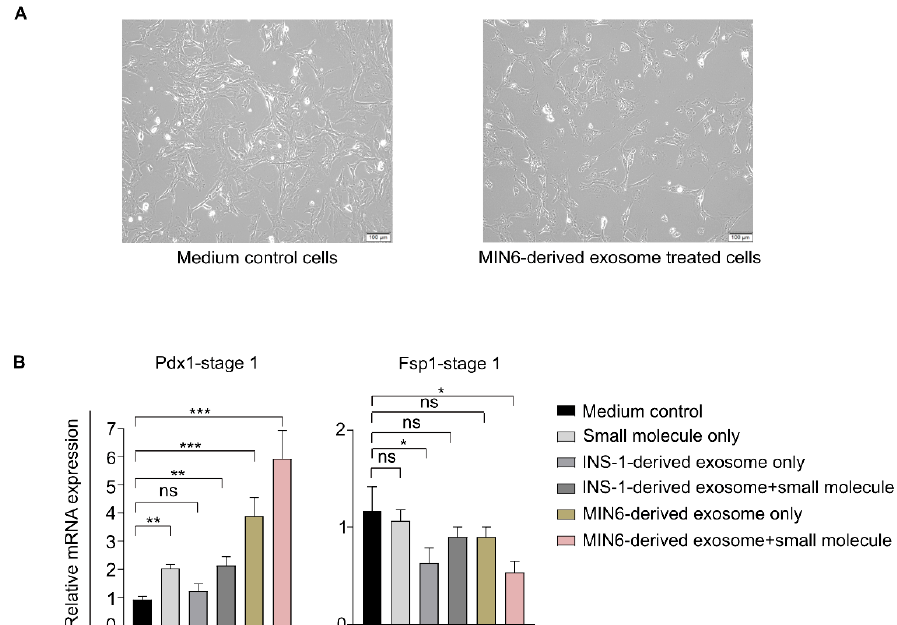
Figure 3. The pancreatic transcriptional program in MEFs treated with insulinoma-derived exosomes. ( A ) Bright-field microscopic images of the medium control and only MIN6-derived exosome-treated MEFs. The insulinoma exosomes (MIN6-derived) did not induce unregulated cellular proliferation in the treated MEFs. Scale bar = 100 µm. ( B ) Relative transcript levels of Pdx1 and Fsp1 in MEFs treated with only small molecules, only exosomes, or the exosome + small molecule combination, compared with the medium control cells in stage 1 of differentiation. * p < 0.05, ** p < 0.01, and *** p < 0.001. Statistical significance was determined by paired, two-tailed t -testing. The data shown represent the mean ± SEM of three independent experiments. ns = non-significant. Stage 1 medium consisted of basal medium + stage 1 small molecules. The medium control cells represent cells grown in basal medium.